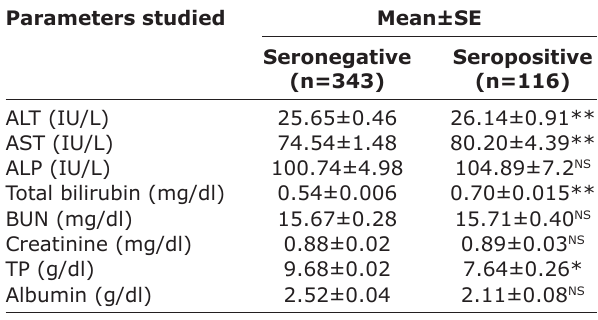
Table-2: Various biochemical parameters studied in goats. Parameters studied